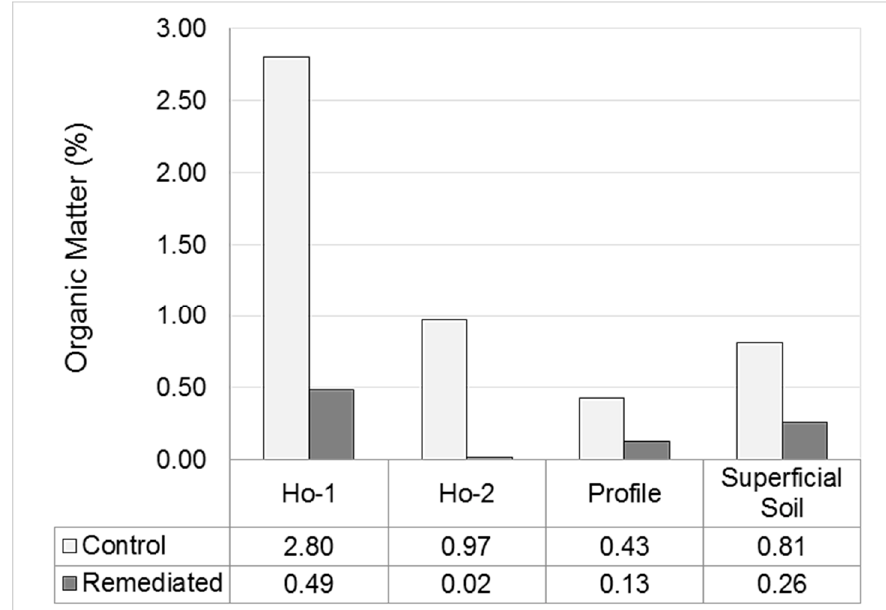
Figure 5. Control and remediated soil horizons, soil profile (0–3 m) and surface soil samples (0–30 cm), soil horizon 1 (Ho-1), soil horizon 2 (Ho-2), soil profile from 0–3 m depth (Profile), superficial soil for 0–30 cm depth (Superficial Soil).